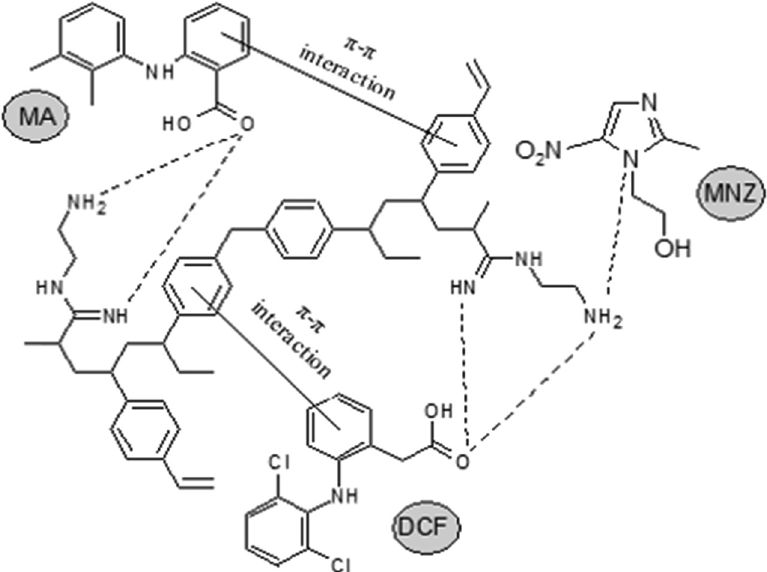
Figure 4: Proposed interaction mechanism of DCF ( diclofenac ) , MA ( mefenamic acid ) , and MNZ ( metronidazole ) toward the active sites of EDA - modi fi ed HXL poly ( AN - co - DVB - 80 - co - VBC )